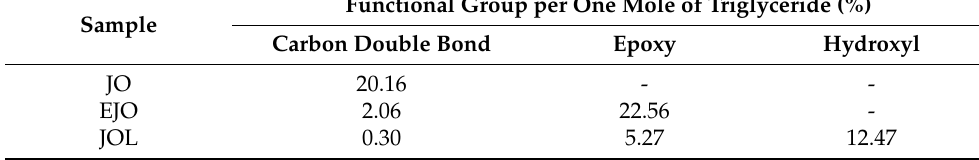
Table 3. Percentages of carbon double bond, epoxy and hydroxyl functional groups in JO, EJO and JOL